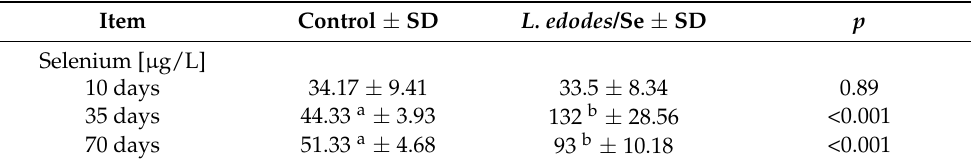
Table 7. Effect of L. edodes /Se on serum selenium concentration ( n = 6).